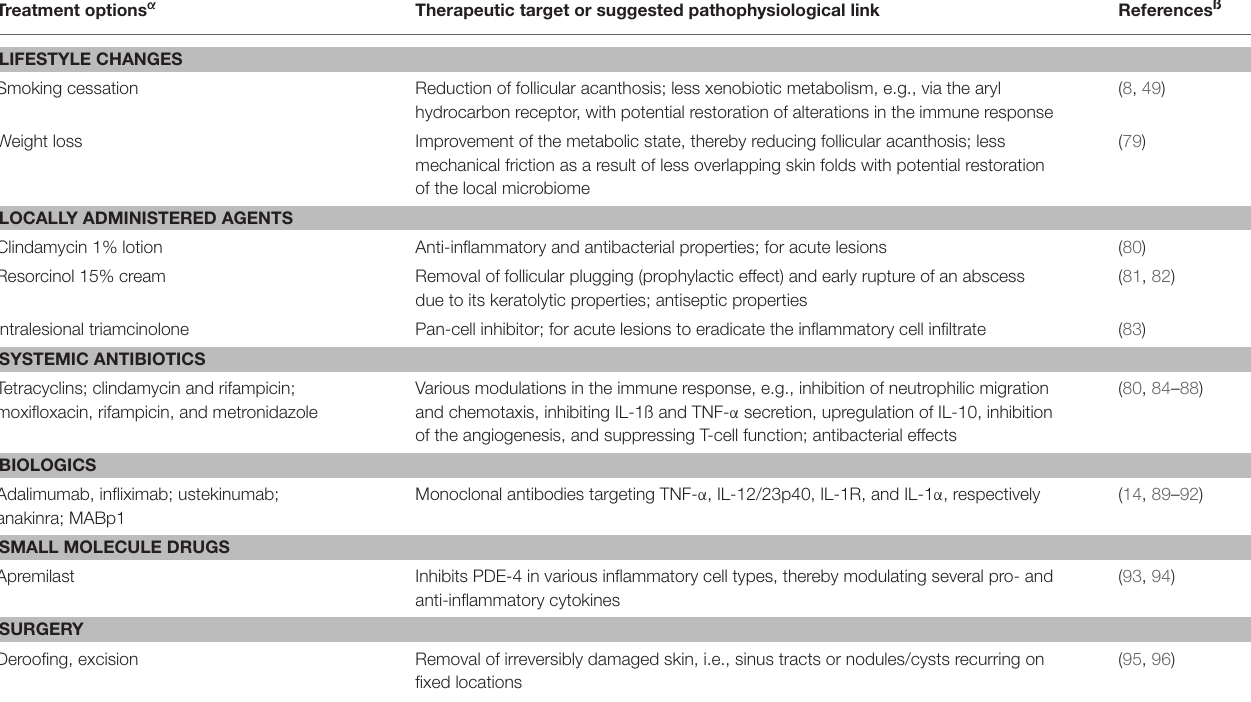
TABLE 3 | Short overview of actual treatment options for hidradenitis suppurativa, based on Van Straalen et al. (78). Treatment options